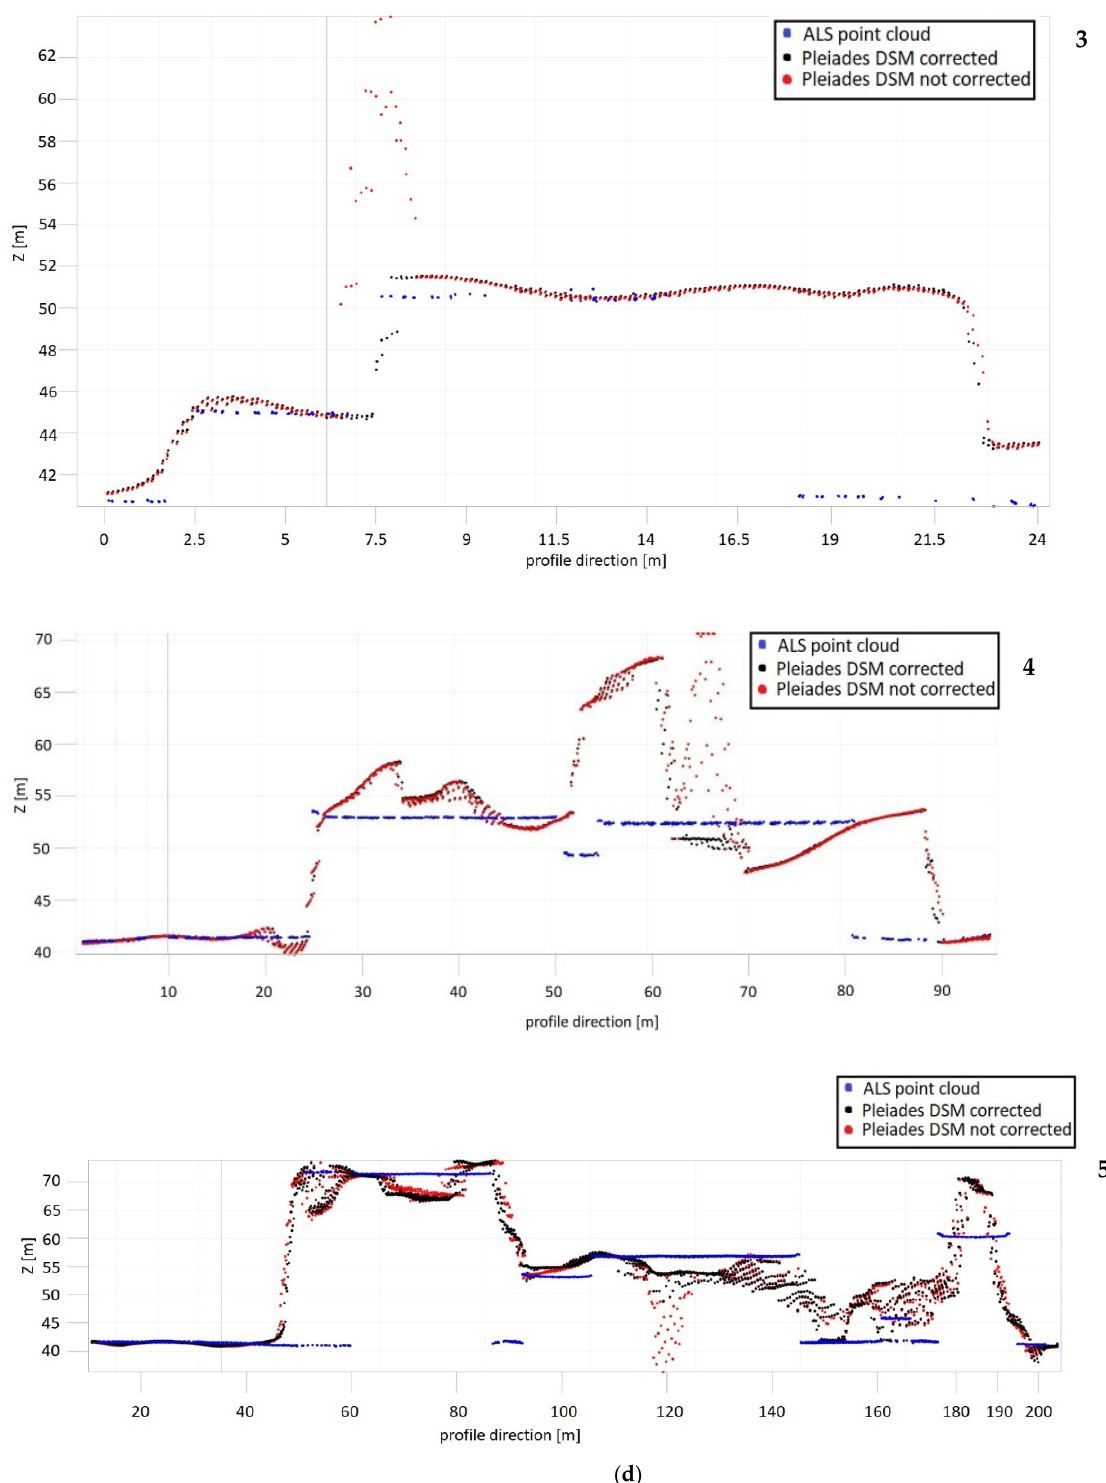
Figure 22. ( a ) HR ALS-DSM point cloud; ( b ) Pl é iades-DSM corrected point cloud; ( c ) Pl é iades-DSM uncorrected point cloud; ( d ) profile of 2 m width of the Pl é iades-DSM point clouds for both corrected and uncorrected scenario pairs in comparison to the reference HR ALS-DSM, for the five analyzed buildings (1-5 labeled profile trajectories highlighted in Figure 21b).